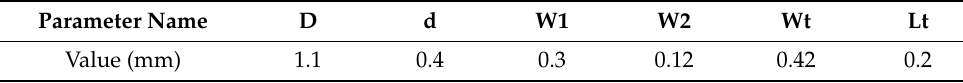
Table 3. Simulation model parameters.